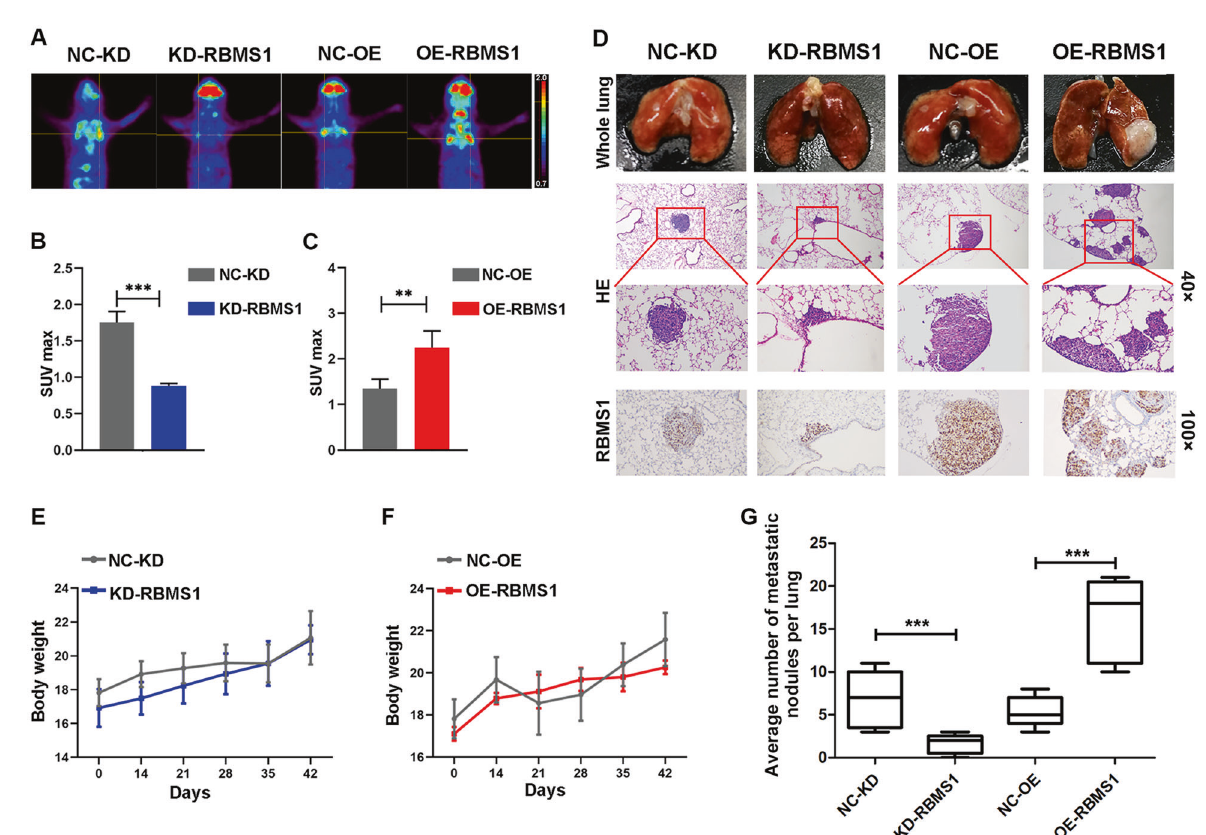
Fig. 5 RBMS1 promotes the lung metastasis of GC cells in vivo. RBMS1-NC, RBMS1-KD, and RBMS1-OE HGC-27 cells were injected via the tail vein to establish a lung metastasis mouse model. Small-animal PET/CT scanner was performed for in vivo imaging 8 weeks after injection. Representative PET/CT images were taken ( A ) and SUV max was calculated ( B , C ). D Mice were killed at 8 weeks after tumor injection to compare the incidence of lung metastasis and tumor weight. Images of a representative lung metastasis mouse model. The IHC staining of the mouse tumor tissues was performed with RBMS1 antibody. Representative images of RBMS1 and H&E staining were shown (magni fi cation ×40 and ×100). E , F The body weight variation in model mice in all groups was recorded. G The number of metastatic lesions in the lung was compared. Lung metastases established from RBMS1-NC cells were considered control groups. Data are mean ± SD for n = 6 mice ** P < 0.01, *** P < 0.001. NS not signi fi cant, NC negative control, KD knockdown, OE overexpression.